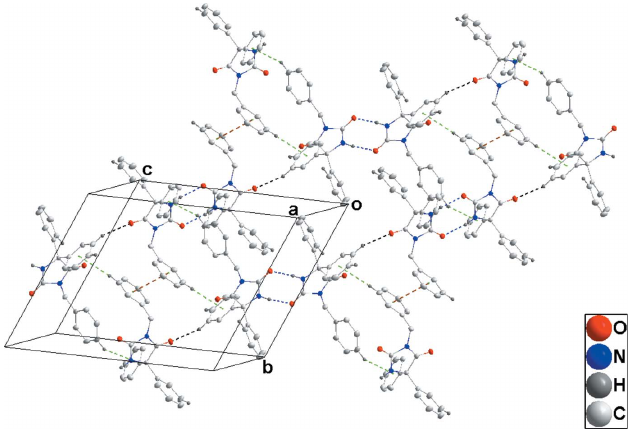
Figure 2 Detail of the interactions forming one corrugated sheet. N—H (cid:2)(cid:2)(cid:2) O and C—H (cid:2)(cid:2)(cid:2) O hydrogen bonds are shown, respectively, by blue and black dashed lines while C—H (cid:2)(cid:2)(cid:2) (cid:2) (ring) and (cid:2) – (cid:2) stacking interactions are shown by green and orange dashed lines.